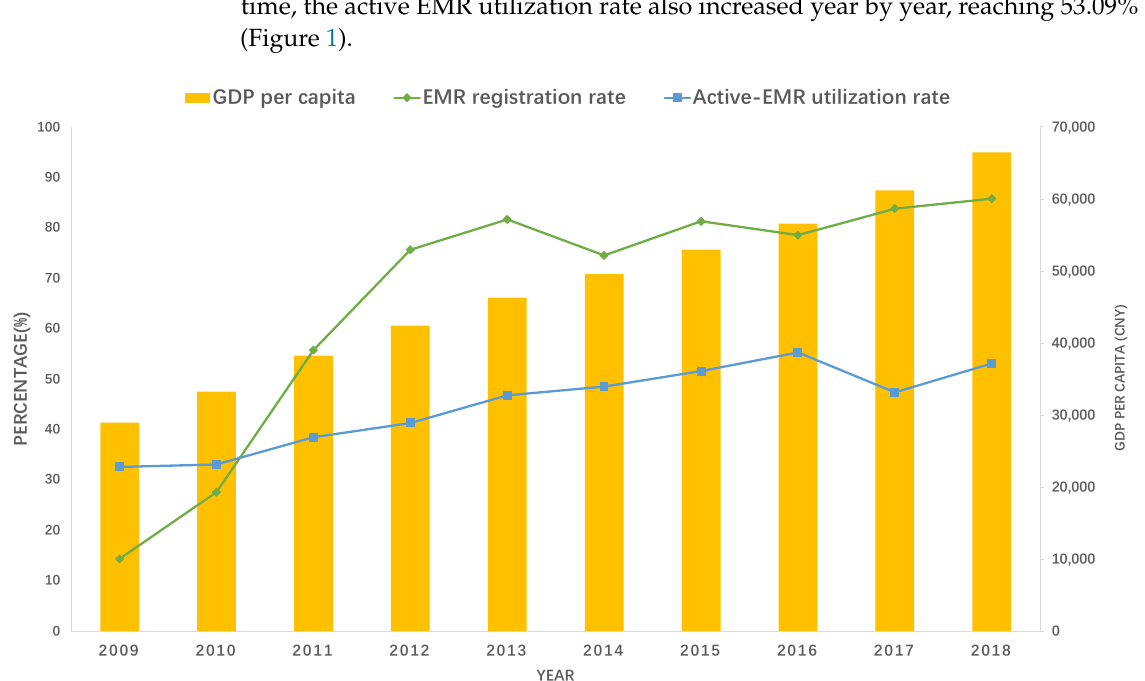
Figure 1. The GDP per capita, EMR registration, and active EMR utilization rates from 2009 to 2018 in Inner Mongolia, China.